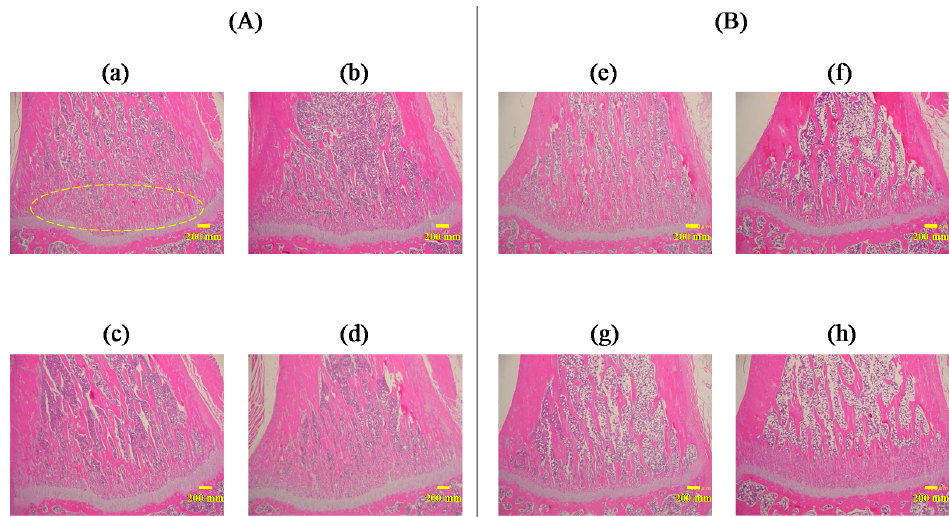
Figure 6. Histological micrographs of bone tissue from the right tibia of rats. ( A ) Preventive effect of ALN on the decrease in the width of the growth plate (circled area) and density of bone structure after administration. (a) Sham (sham-operated), (b) OVX (ovariectomized), (c) weekly oral administration of ALN just after OVX, (d) weekly application of ALN(TIP)–MN just after OVX. All groups were evaluated 4 weeks after sham or OVX operation. ( B ) Therapeutic effect of ALN on the decrease in the width of the growth plate and density of bone structure after administration. (e) Sham, (f) OVX, (g) weekly oral administration of ALN 4 weeks after OVX, (h) weekly application of ALN(TIP)–MN 4 weeks after OVX. All groups were evaluated 8 weeks after sham or OVX operation. Original magnification: 40×. Scale bar: 200 µm. Representative data are shown from one of three experiments.